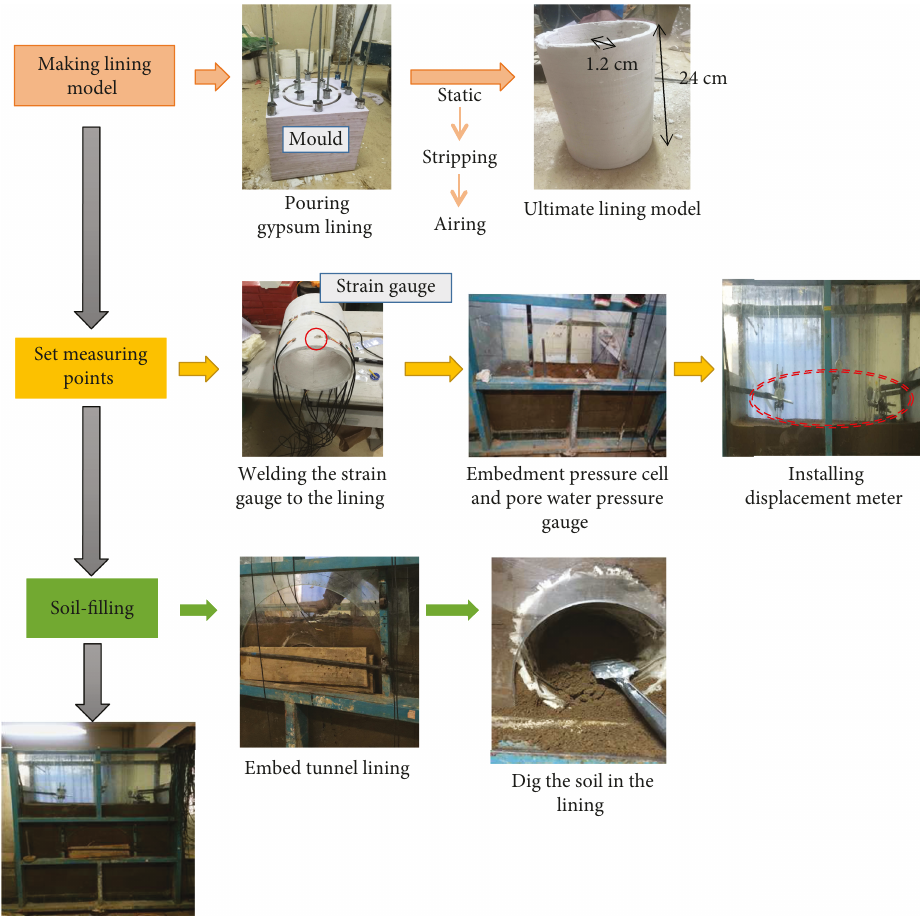
Figure 7: Experiment procedure.